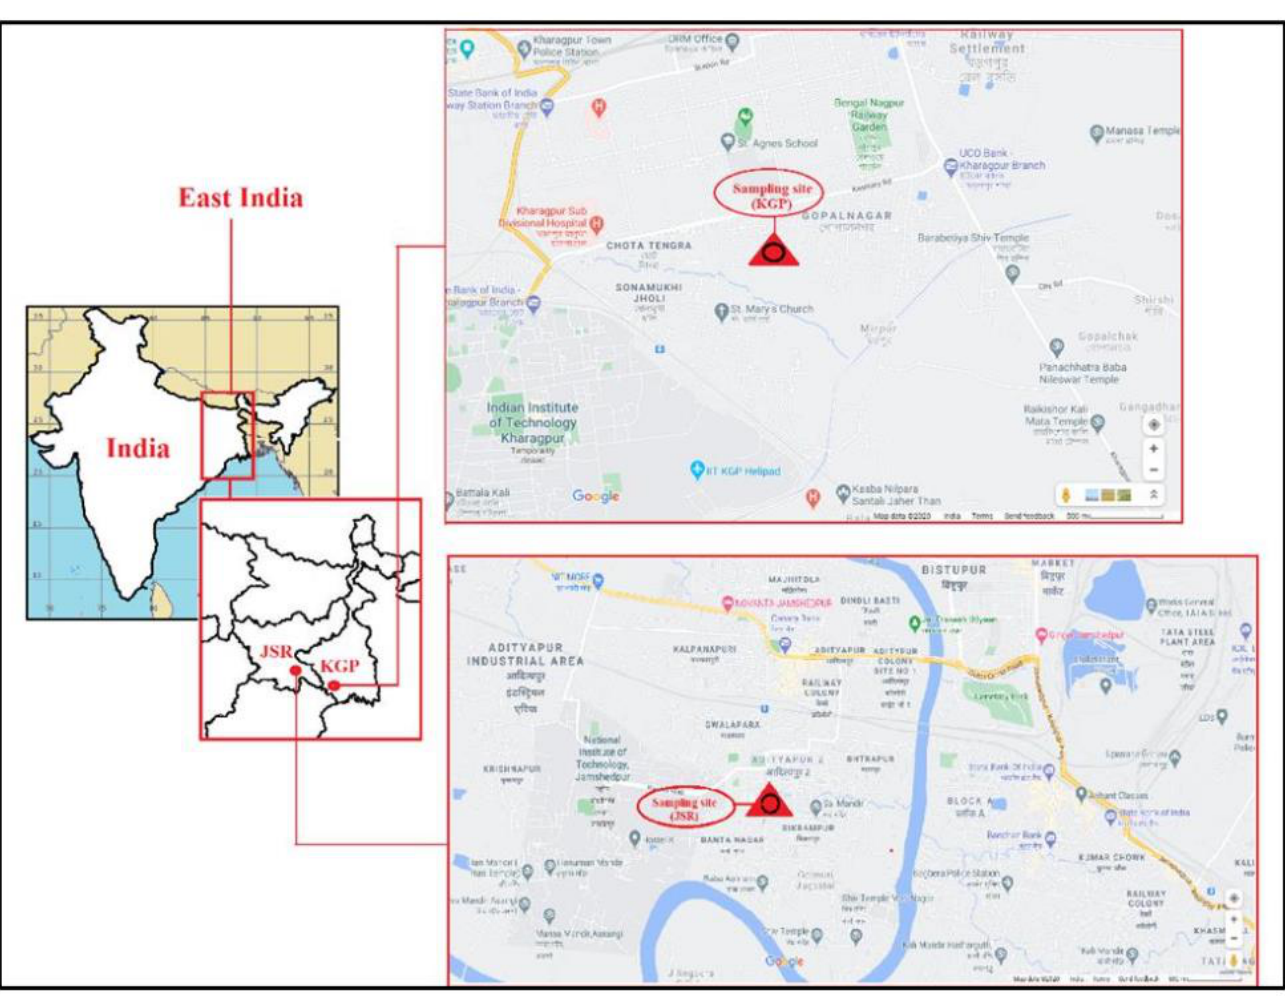
Figure 1. Locations of JSR and KGP observation sites and surrounding regions (courtesy google map; assessed on 1 August 2022).